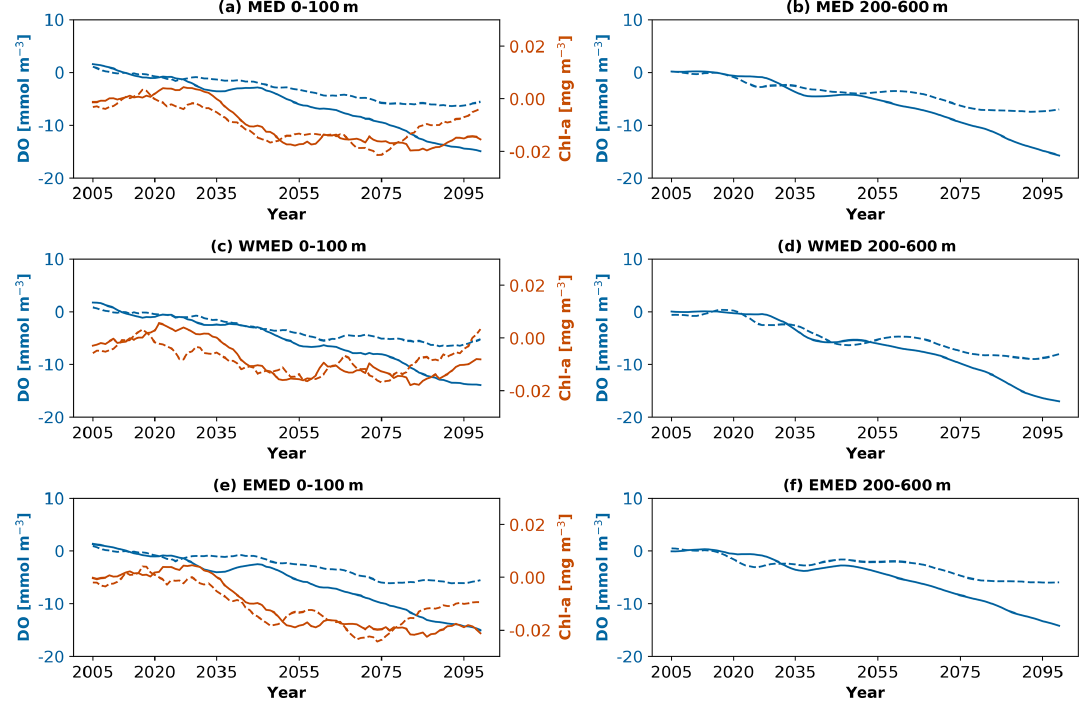
Figure 8. As Fig. 7, but for dissolved oxygen (blue, in mmolm − 3 ) and Chl- a (dark orange, in mgm − 3 ).